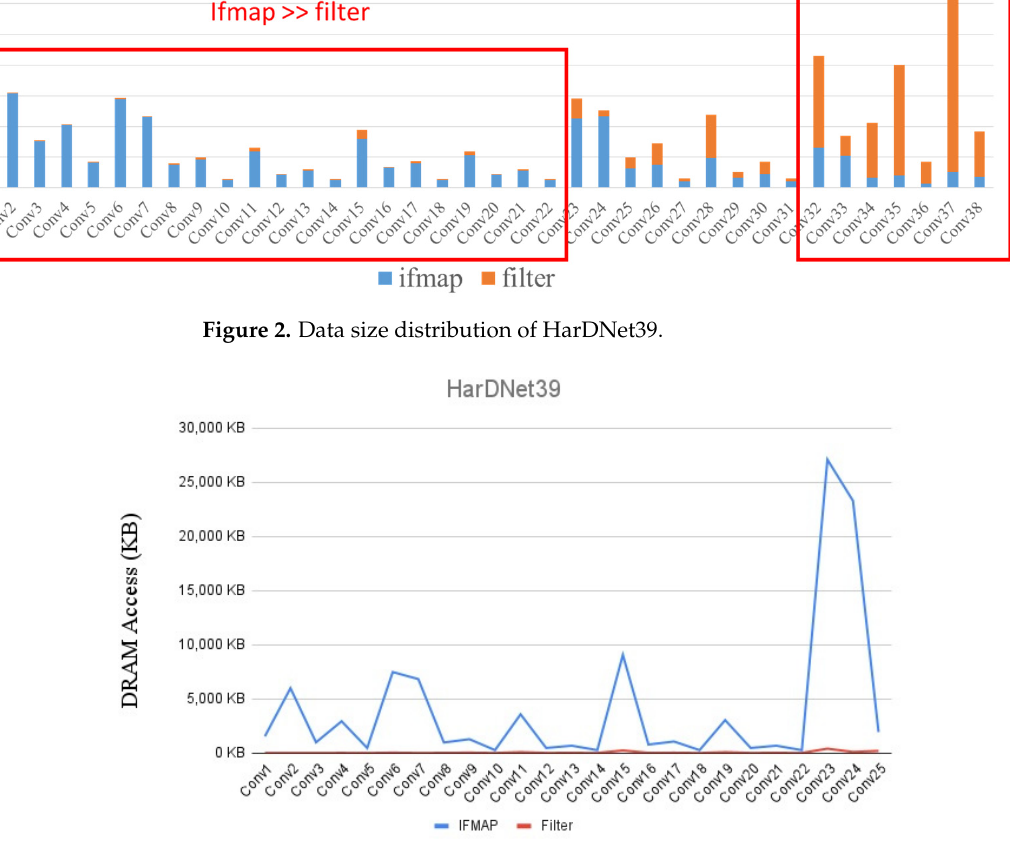
Figure 3. DRAM access distribution of HarDNet39.